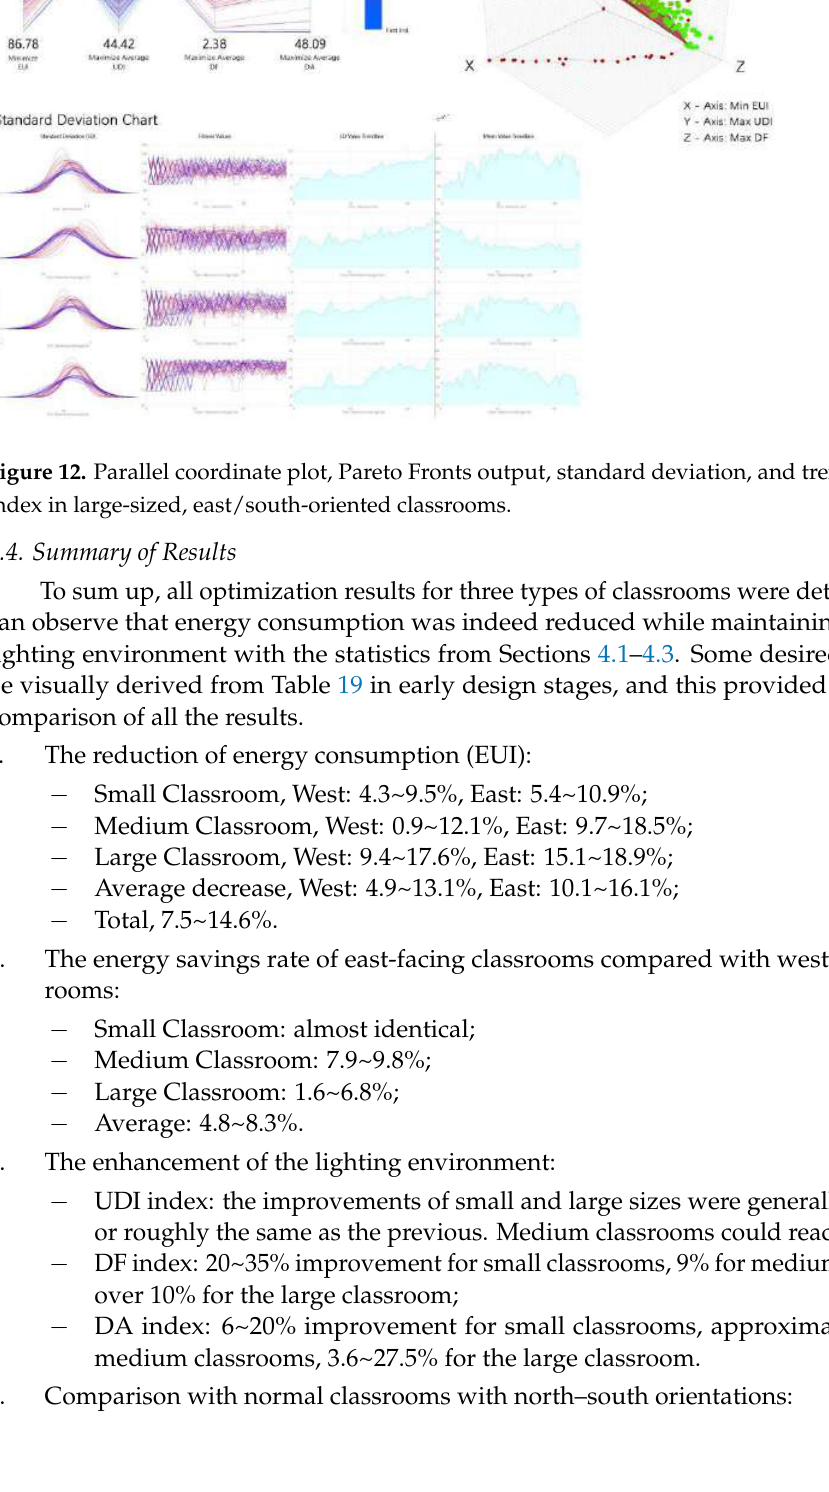
Table 18. Genomes in detail and phenotype outputs for large-sized classrooms with east and south facade fenestration. Large Class- room